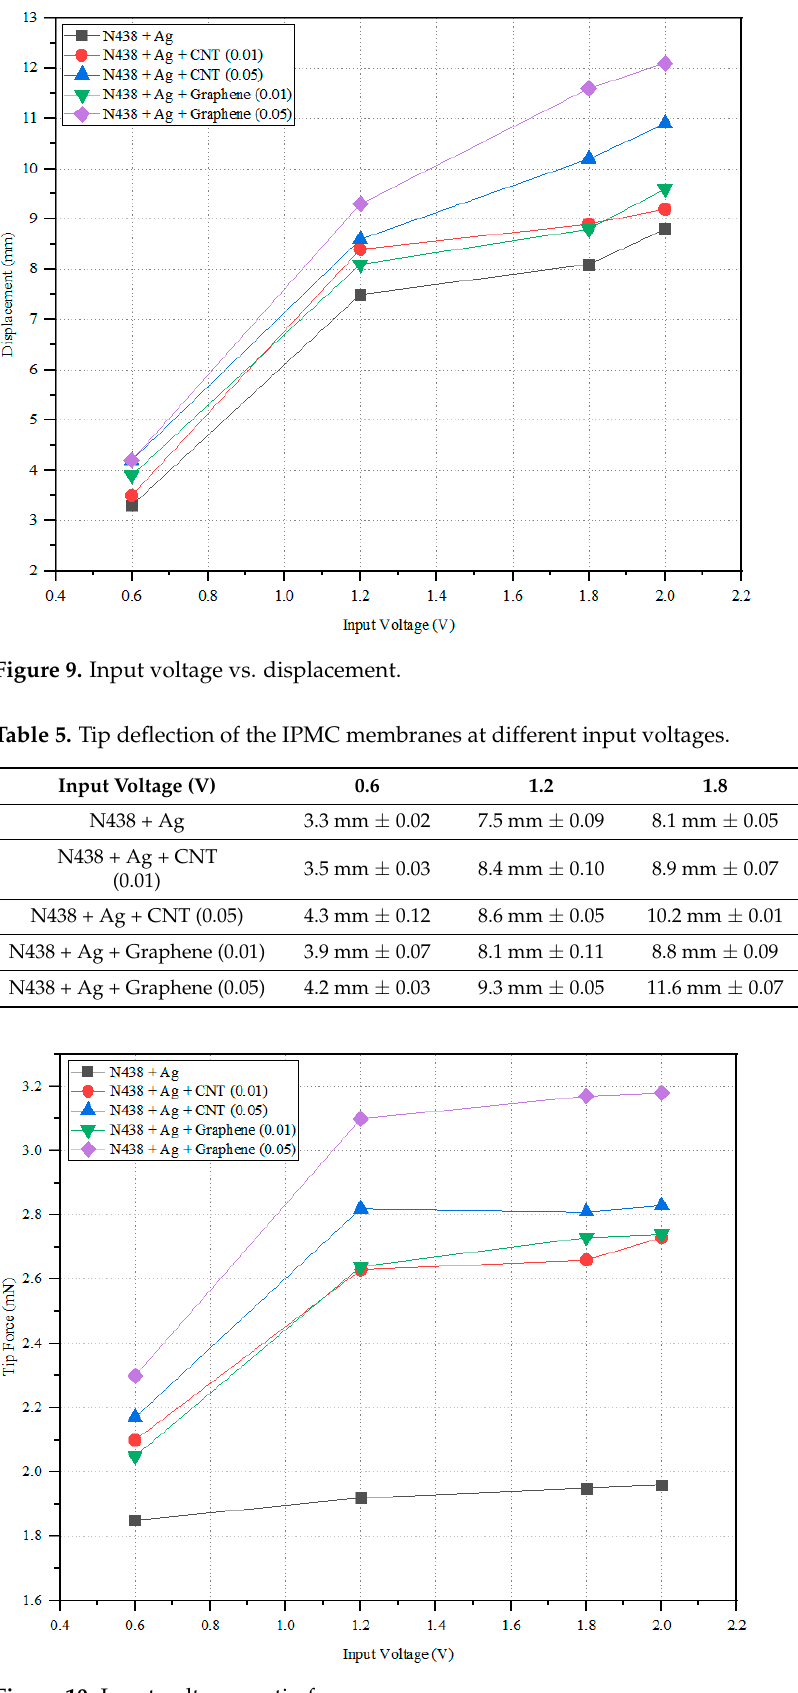
Figure 10. Input voltage vs. tip force. Table 6. Tip force of the IPMC membranes at different input voltages.